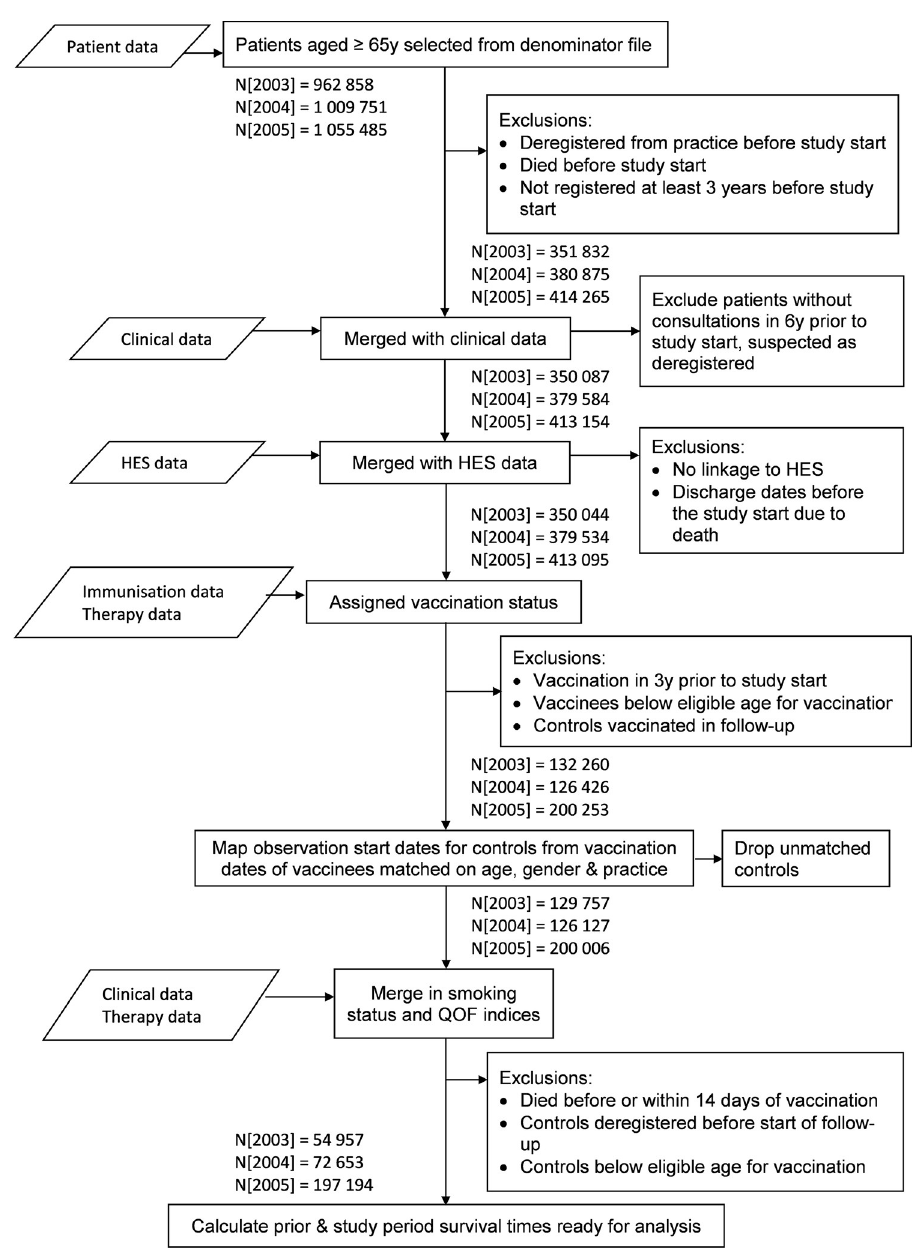
Fig 3. Flowchart for the three cohorts